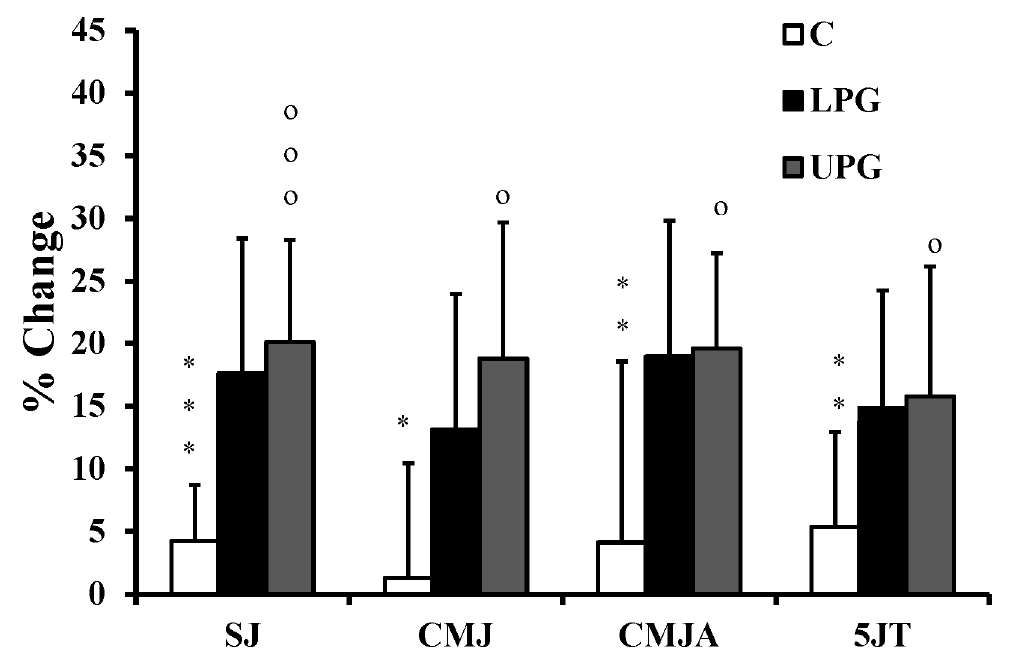
Figure 6. Training associated changes in vertical (SJ: Squat Jump, CMJ: countermovement jump: CMJ; CMJA: countermovement with aimed arms) and horizontal jumps (5JT: Five jump test) in loaded plyometric group (LPG), unloaded plyometric group (UPG) and controls (C). * = denotes a significant difference between LPG and C; + = denotes a significant difference between LPG and UPG; o = denotes a significant difference between UPG and C; *: p < 0.05; **: p < 0.01; ***: p < 0.001; o: p < 0.05; ooo: p < 0.001.